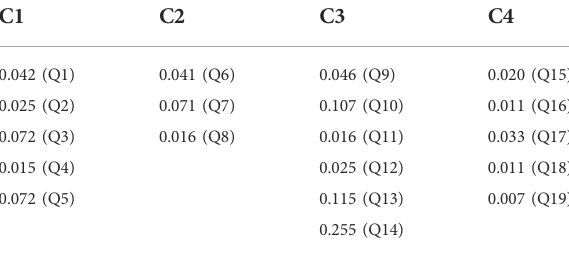
TABLE 4 Weighting result of analytic hierarchy